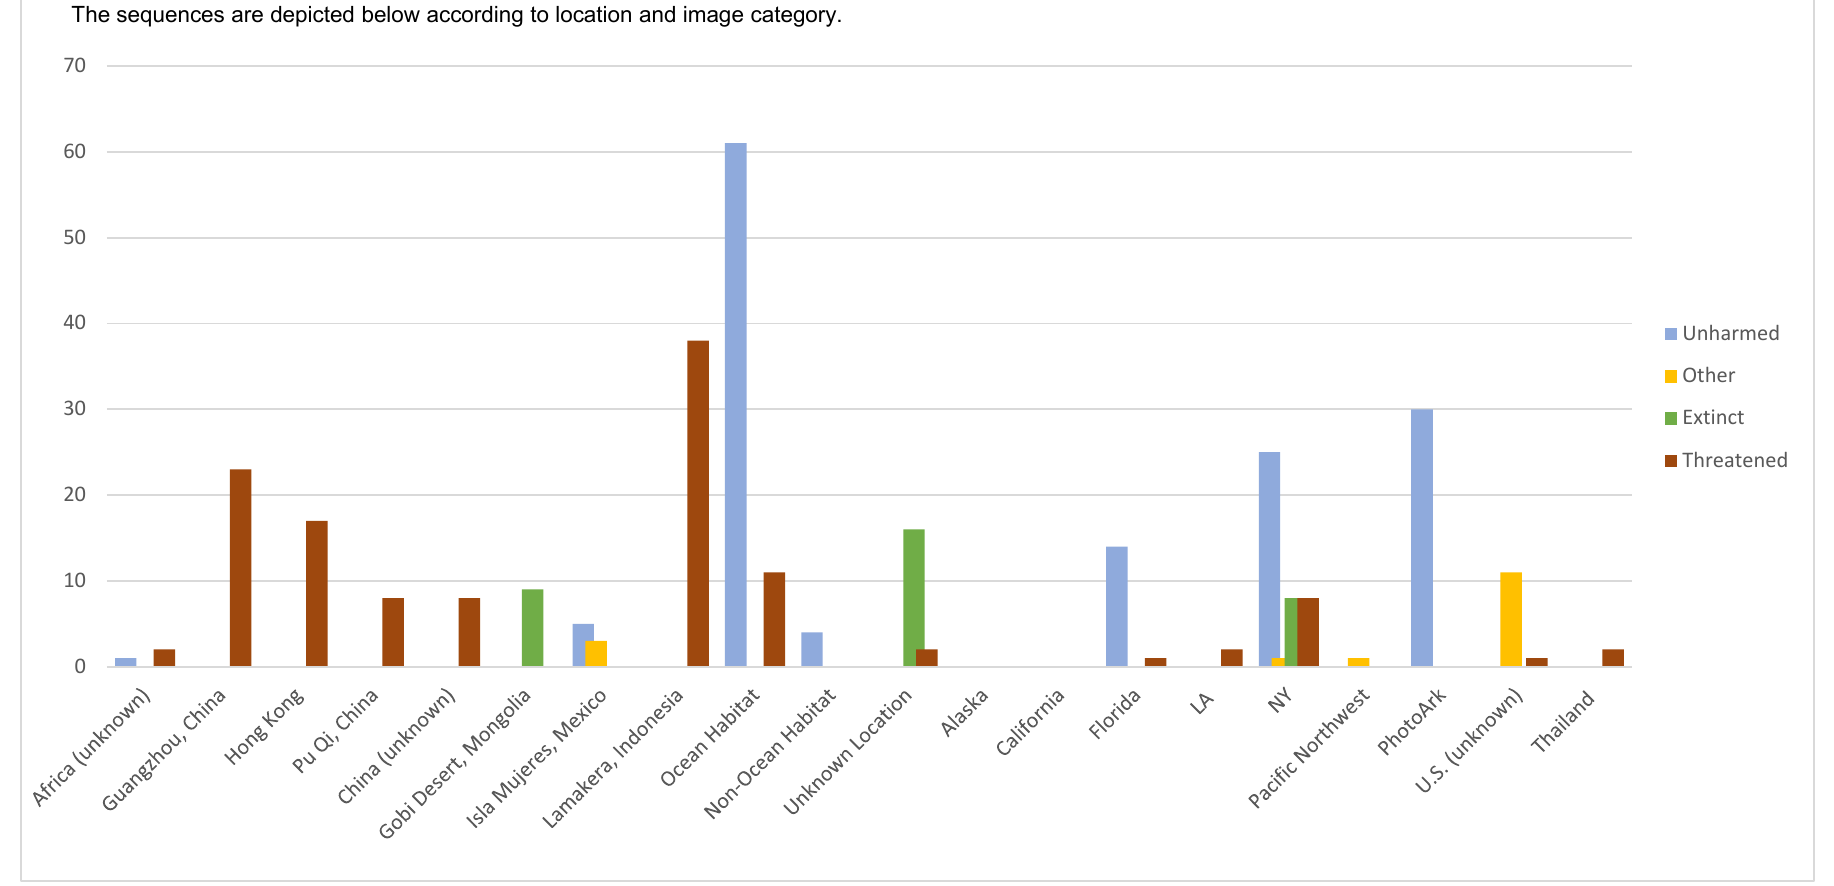
Figure 1. Racing Extinction’s Animal Imagery.